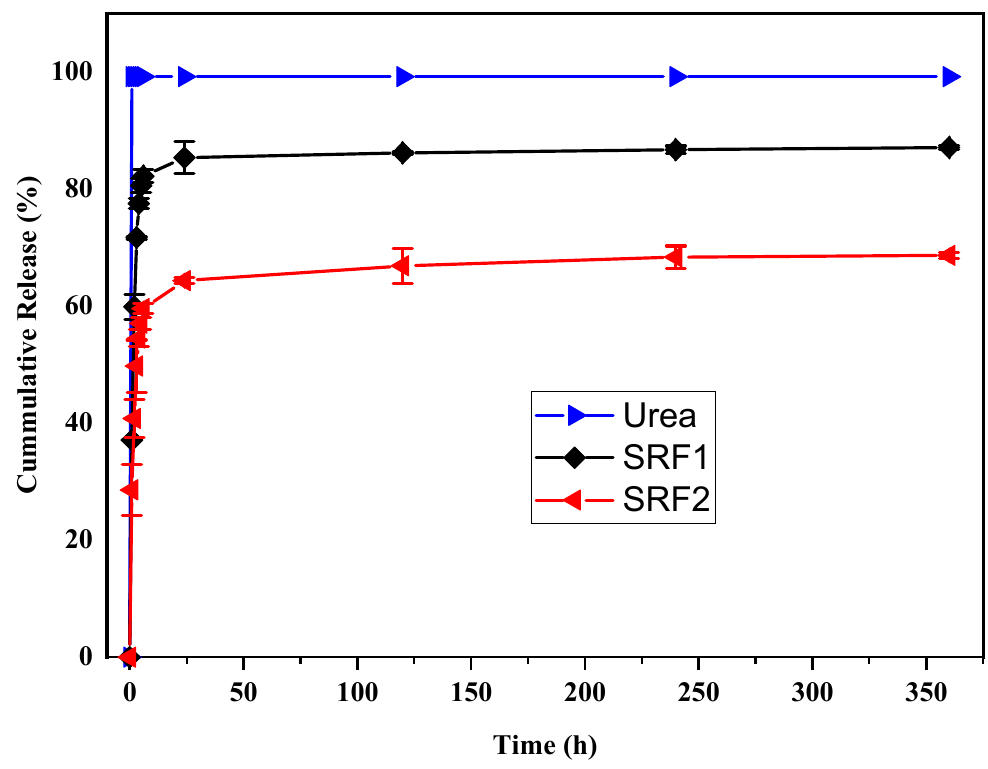
Figure 7. Release behavior of urea, srf1 without paper and srf2 with blended paper in water.